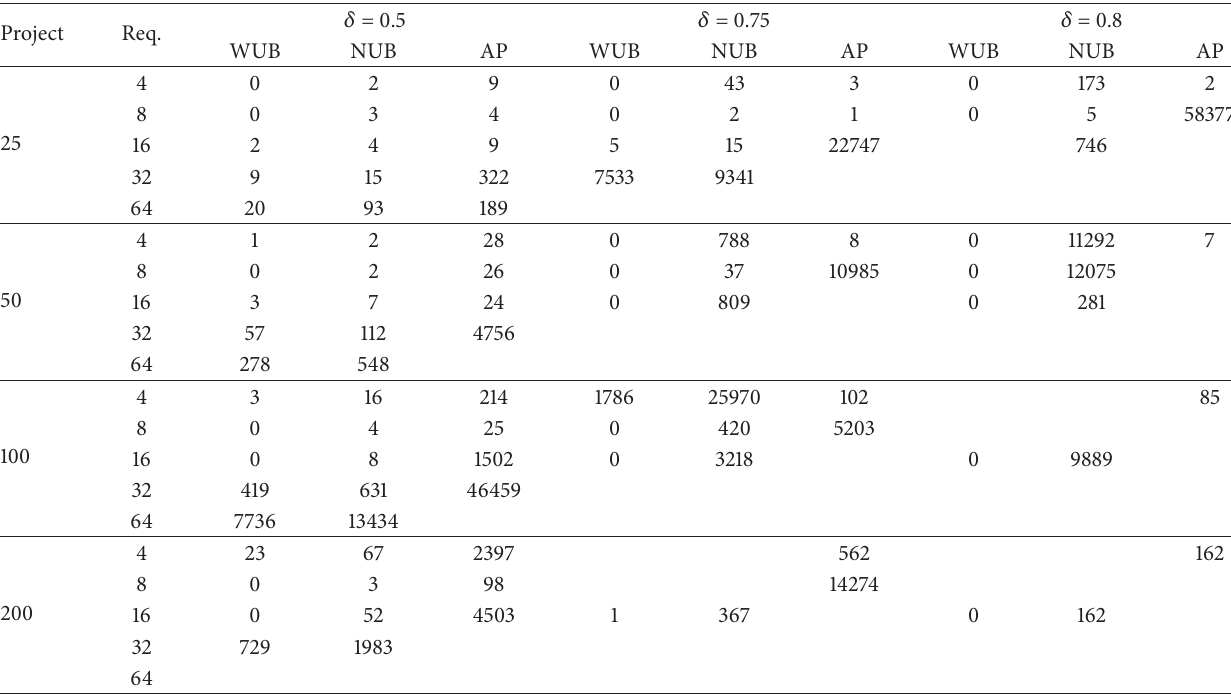
Table 1: Time in (ms) to find solutions as a function of 0’s density ( 𝛿 ).